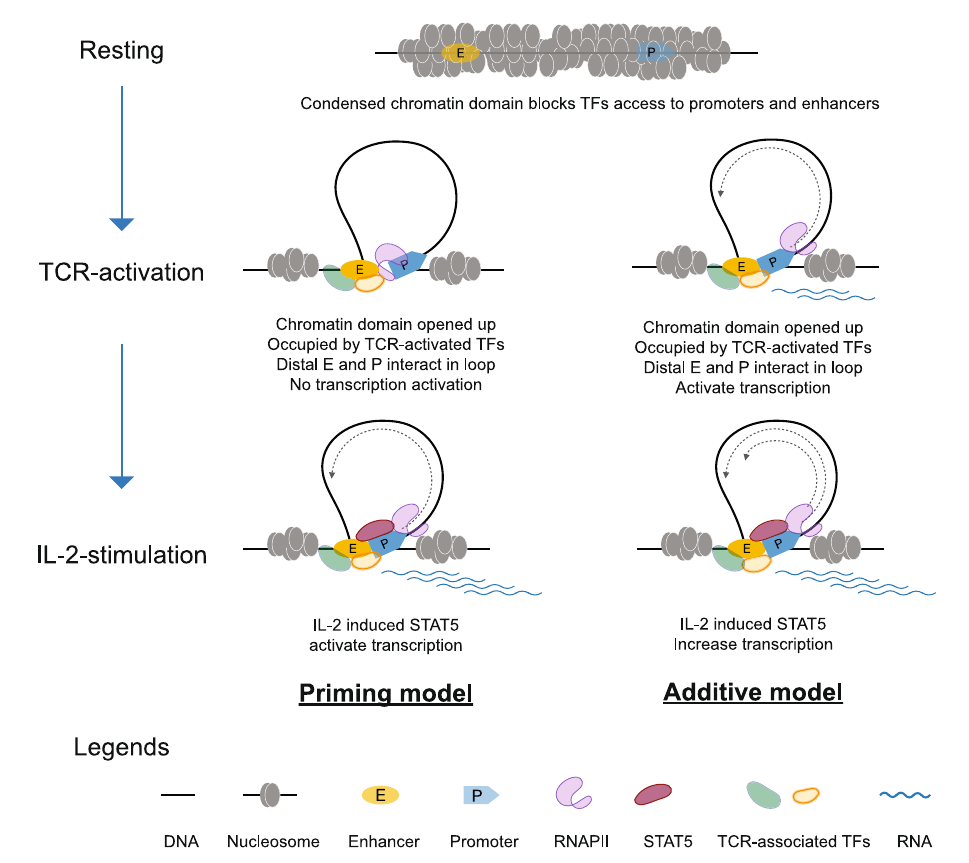
Fig. 6 | Proposed topological models for IL-2-speci fi c transcription regulation. Schematic illustration of the proposed two topological models for gene tran- scription activation stimulated by IL-2 following TCR activation in CD4 + T cells. In resting stage of CD4 + T cells, the chromatin domains harboring IL-2-speci fi c genes may be in a condensed form that suppresses gene transcription. After TCR-acti- vation, the chromatin domains may be remodeled by several pioneering TFs and opened up to be accessible to RNAPII and co-activators. While some of the